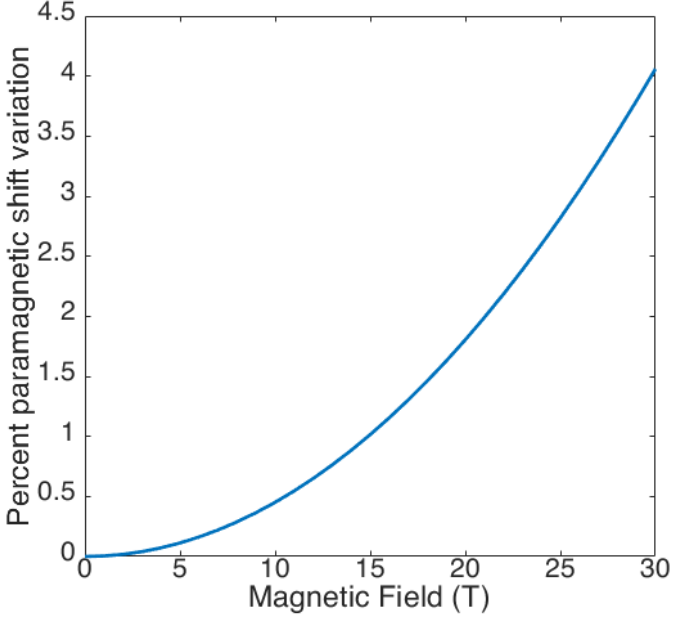
Figure 3. Percent variation of the paramagnetic shifts (both PCS and FCS) as a result of field-induced orientation, calculated using the magnetic susceptibility anisotropy reported for the archetypical SIM terbium(III) phthalocyaninato [52].